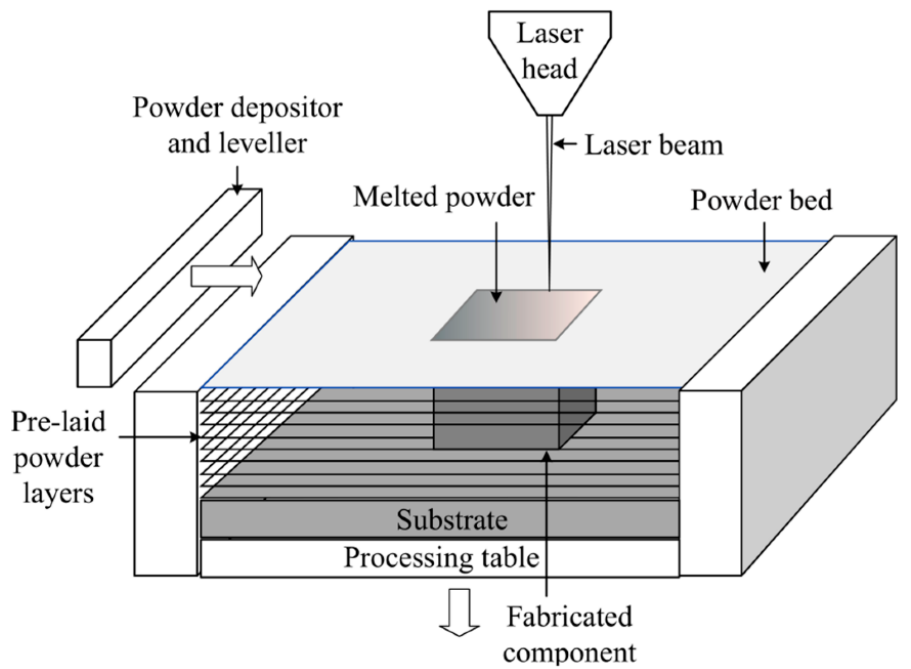
Figure 1. Powder bed fusion process schematic [17]; published under MDPI open-access license.